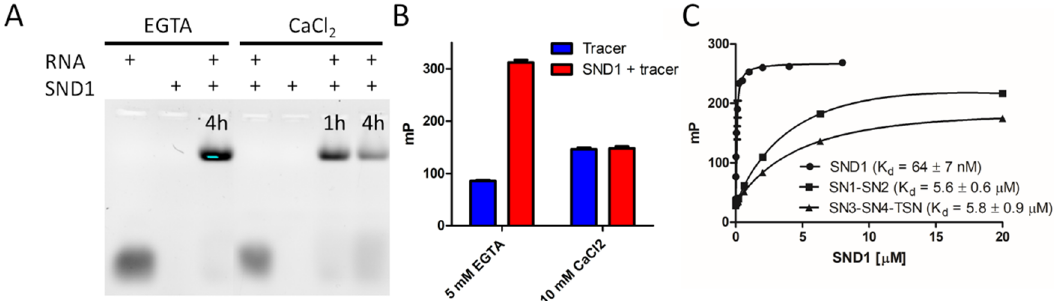
Figure 3. SND1 binds and cleaves fluorescently labelled RNA. ( A ) RNA binding and degradation of SND1 analyzed by EMSA. An amount of 2 µM of fluorescently labeled RNA was mixed with 2 µM SND1 either with 5 mM EGTA or with 5 mM CaCl 2 and incubated for 1 or 4 h followed by separation with 20% PAGE. The fluorescence of the miRNA was detected with an imager. Controls consisting of 2 µM RNA or 2 µM SND1 alone were separated on the gel without prior incubation. ( B ) FP assay using the same fluorescently labelled RNA tracer. Binding of the tracer to SND1 increases polarization in the presence of EGTA but not in the presence of CaCl 2 . ( C ) Binding affinities of SND1, SN1-SN2, and SN3-SN4-TSN to the RNA tracer measured with the FP assay.